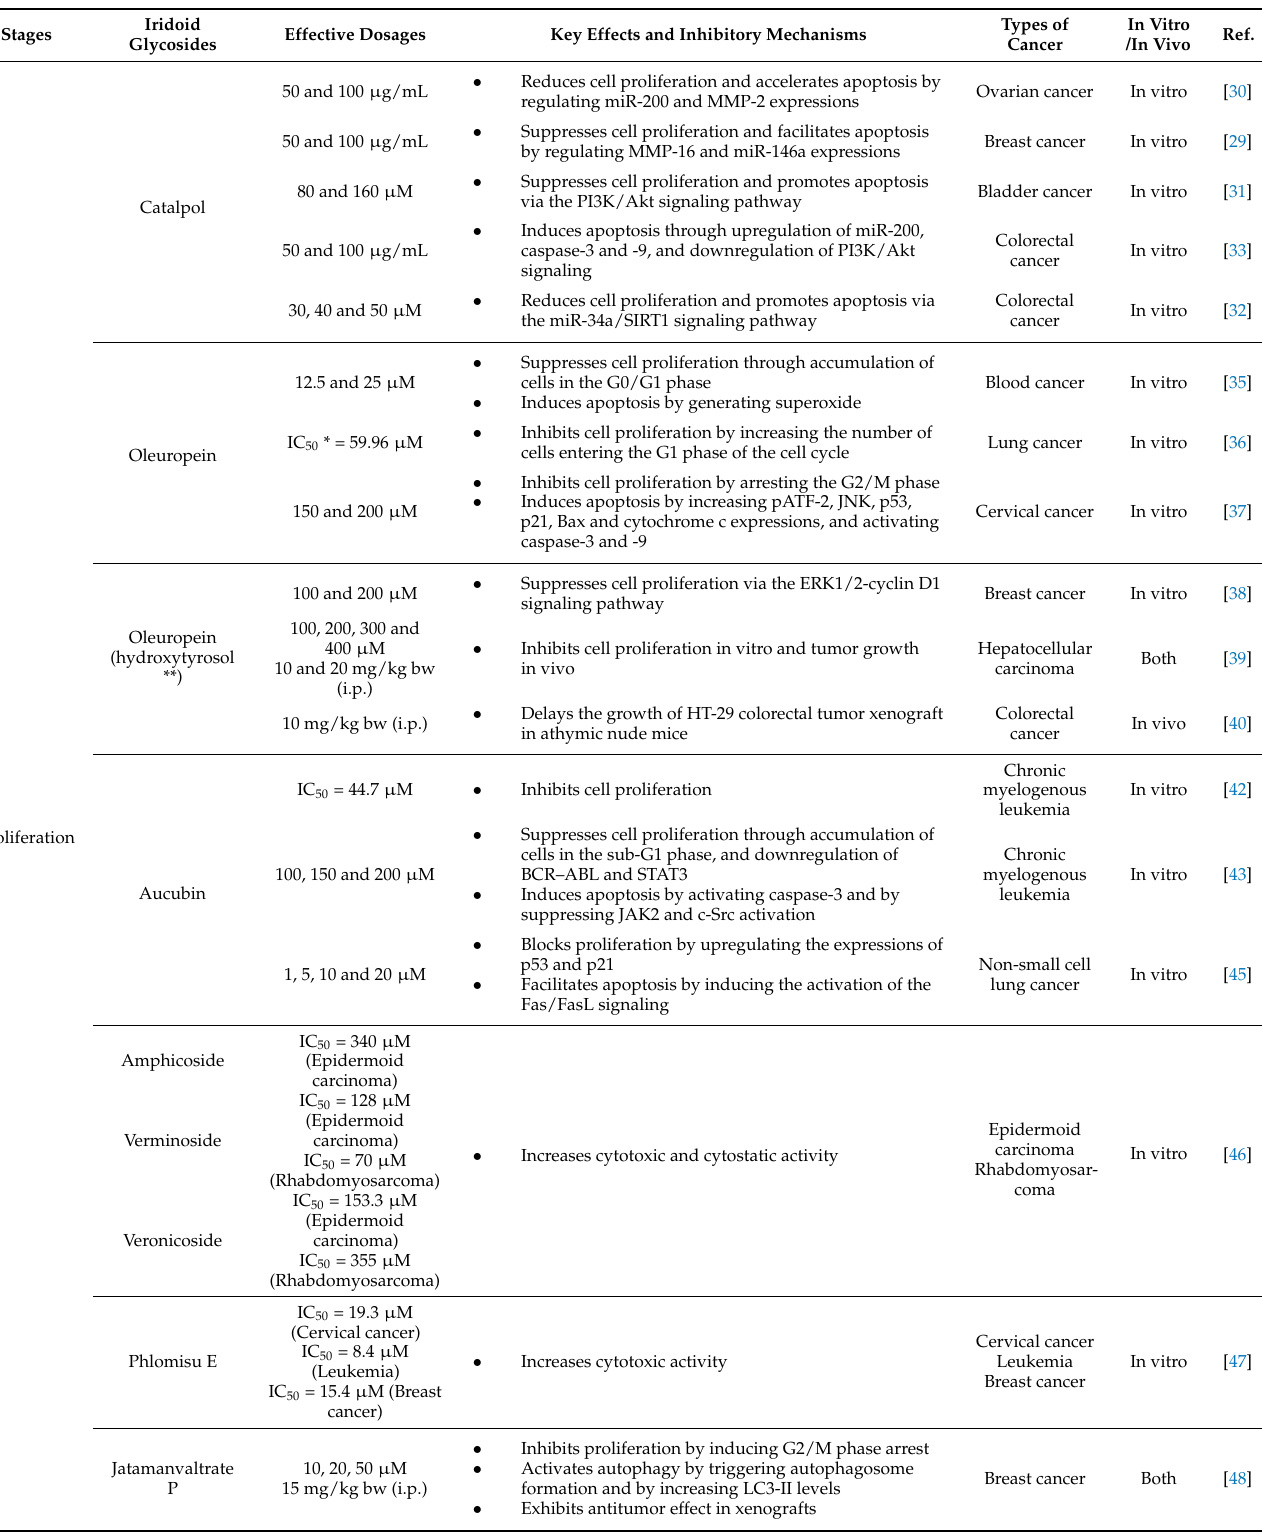
Table 1. Inhibitory effects and mechanisms of iridoid glycosides at each stage of cancer development.